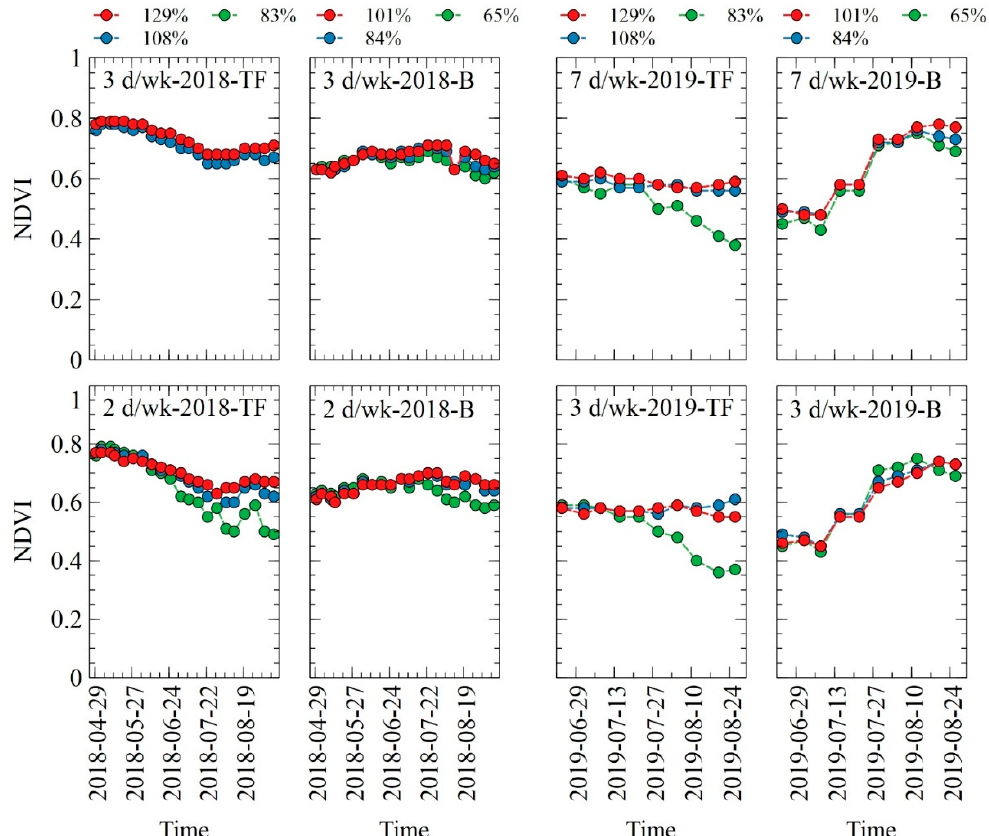
Figure 4. NDVI values showing the response of hybrid bermudagrass and tall fescue turfgrass to varying irrigation levels (ET o %) and frequency (d/wk: days per week) imposed in 2018 and 2019. TF: tall fescue, B: hybrid bermudagrass. Table 3. Statistical analysis of the hybrid bermudagrass and tall fescue response (NDVI and canopy temperature) to irrigation treatments imposed in years 2018 and 2019 (each year was analyzed separately). Tall Fescue Hybrid Bermudagrass NDVI Canopy Temp. NDVI Canopy Temp.